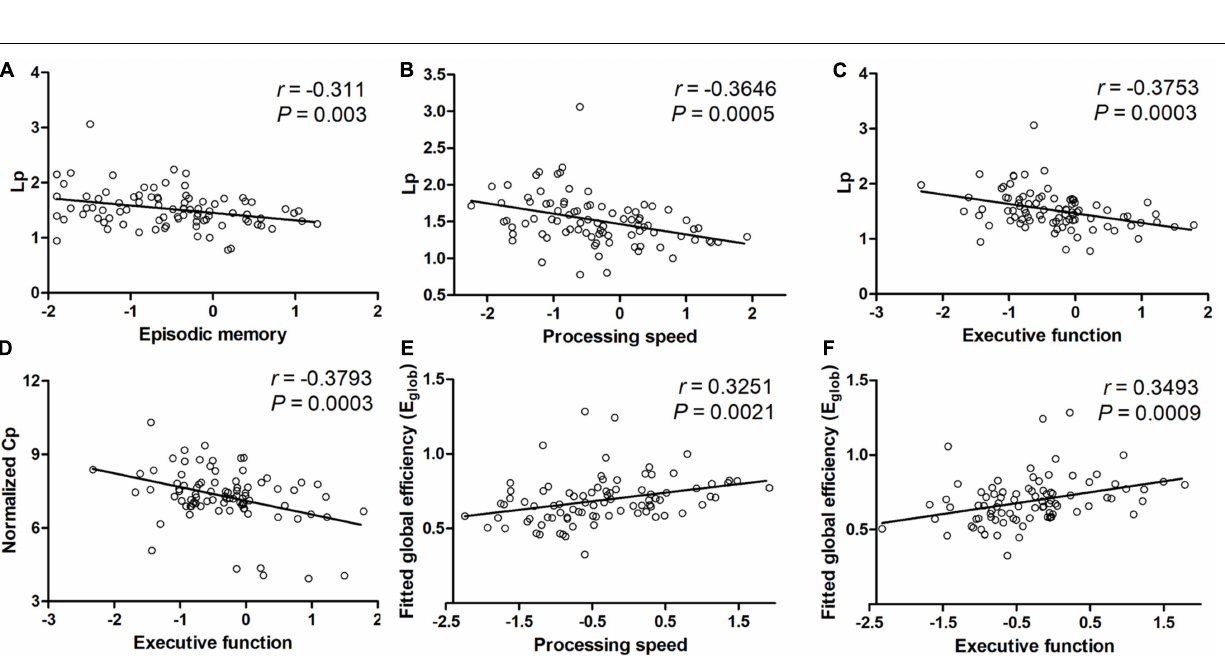
FIGURE 2 | Brain regions identified as abnormal nodal efficiency in ILA. Red nodes show the regions of reduced efficiency in patients with ILA relative to healthy controls. The node sizes denote the significance of between-group differences in the regional efficiency. For the abbreviations of nodes, see Supplementary Table 2 . L, left ; R, right .